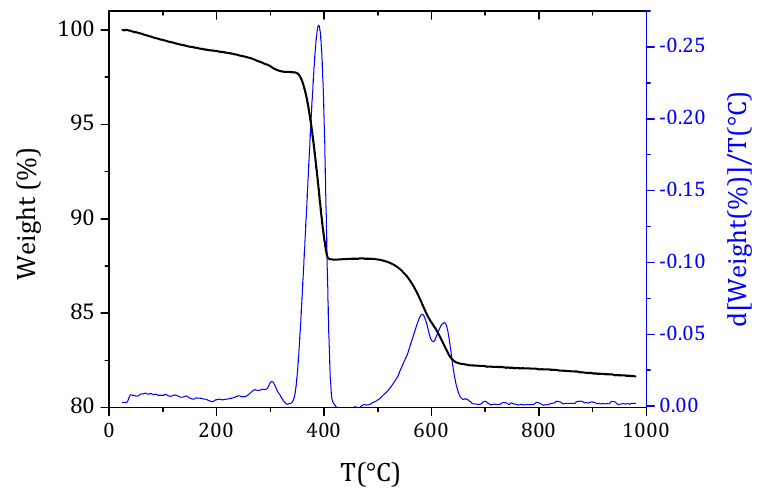
Figure 2. TGA/DTG of NHL5 produced by Otterbein, Germany.